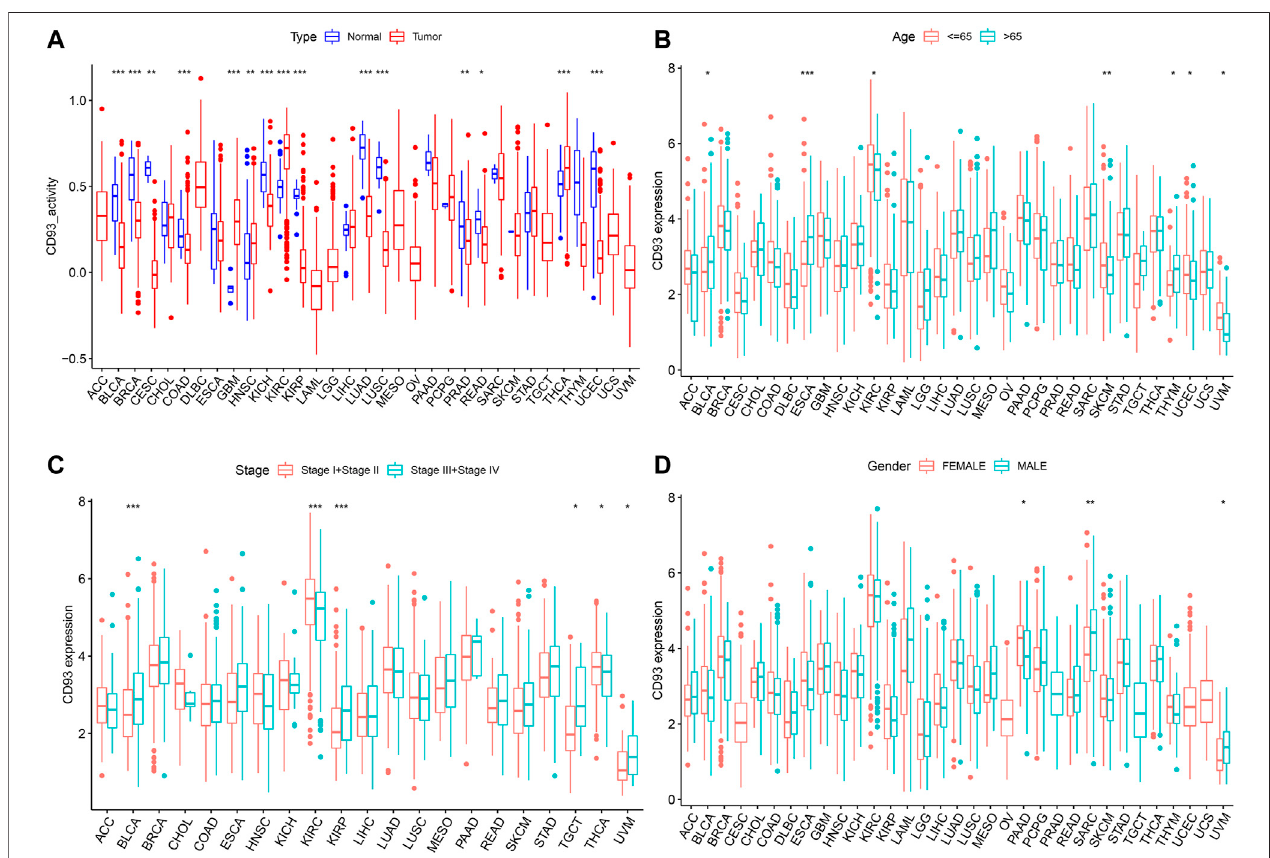
FIGURE 3 | Relationship between the expression level of CD93 and clinical characteristics. (A) Differential analysis of CD93 expression activity between cancer tissue and adjacent normal tissue. (B – D) Correlation between age, tumor stage, and gender with CD93 expression. * p < 0.05, ** p < 0.01, *** p < 0.001.